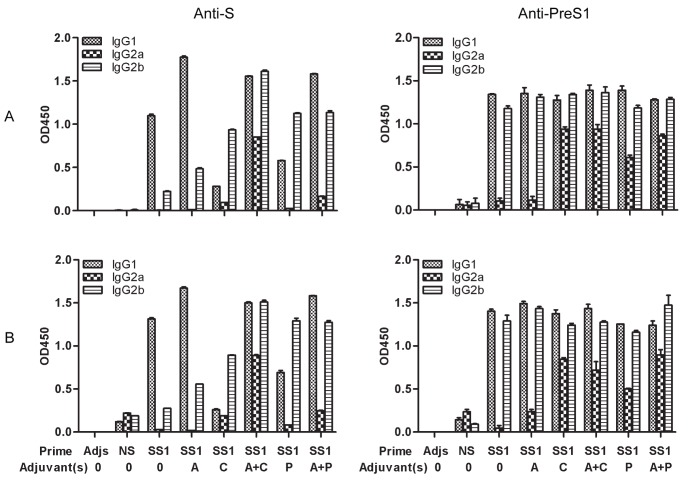
Subtype analysis of the HBV antigen-specific IgGs (anti-S and anti-PreS1) in sera of immunized mice before and after rAdSS1 boosting.(A) Sera were collected at 2 weeks after the 2nd priming; (B) Sera were collected at 2 weeks after rAdSS1 boosting. Sera were diluted 1∶100. Bars indicate the average OD at 450 nm (OD450) of each group. SS1: HBSS1. A, alum; C, CpG; P, poly(I:C). Adjs: control group with adjuvants mixture.